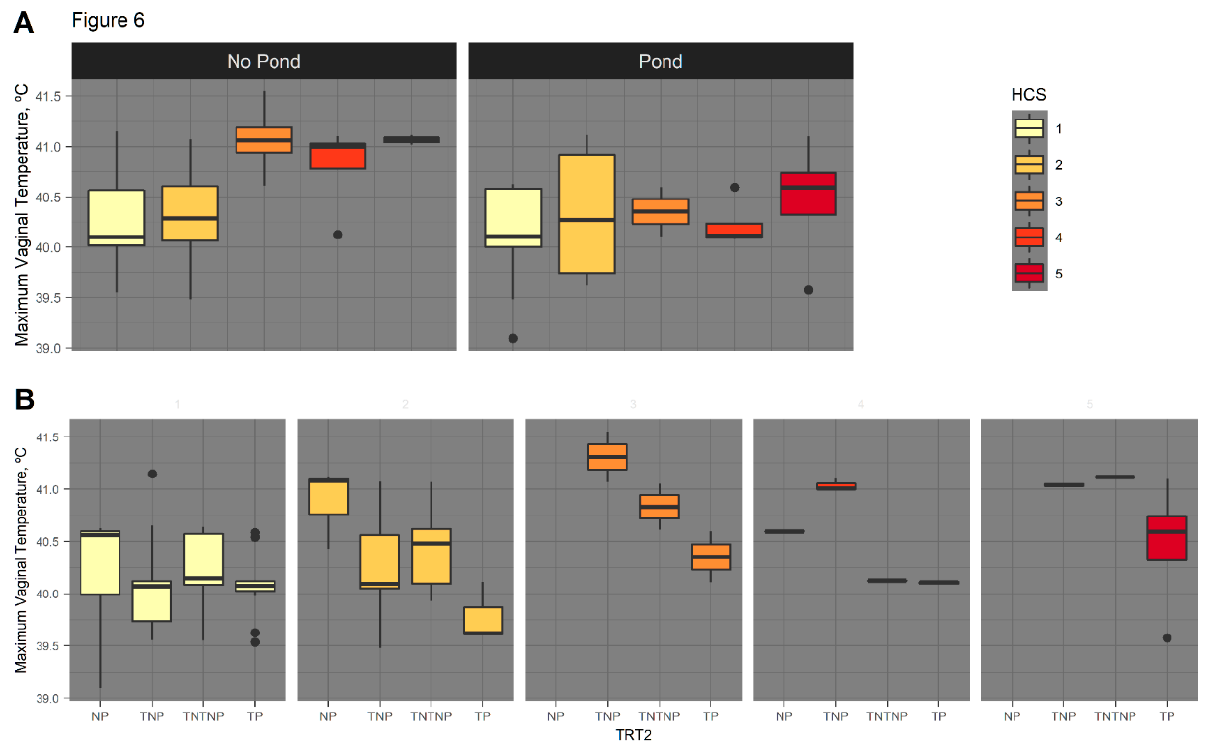
Figure 6. Serial vaginal temperature maximums increase as August hair coat scores (HCS) increase and vary with pond availability and fescue treatment. As serial vaginal temperatures were recorded during times of pond usage, the Trt2 variable creates four treatment categories: toxic pasture with a pond (TP), novel pasture with a pond (NP), toxic pasture with no pond (TNP), and TNT with no pond (TNTNP). ( A ) Cows were grouped solely on pond availability, with HCS 1 through 5 represented in each group. Cows with no pond access indicate a positive correlation between August HCS and maximum vaginal temperature, with a reduced ability to reach thermoneutral, as indicated by the smaller temperature range for all HCS. Cows with pond access have similar maximum temperatures, indicating pond usage as a cooling mechanism, regardless of HCS. ( B ) Maximum vaginal temperatures by August HCS and TRT2 classification. Cows on toxic fescue not only have elevated maximum vaginal temperatures, but are more likely to retain thicker HCS, further exaggerating this difference.